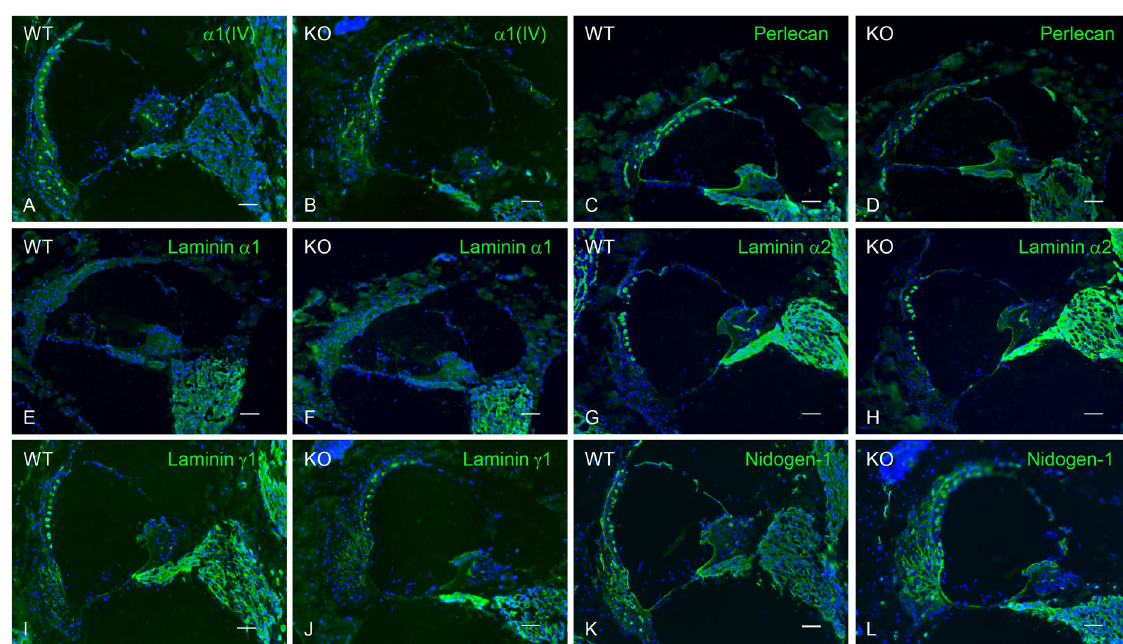
Fig 7. Distribution of major basement membrane components in the cochlea of WT and Col4a6 KO mice. Cryosections were immunostained by antibodies against collagen α 1(IV) chain (A, B), perlecan (C, D), laminin α 1 (E, F), laminin α 2 (G, H), laminin γ 1 (I, J), and nidogen-1 (K, L). Nuclei were counterstained with Hoechst 33258 (blue). No differences are apparent between WT and Col4a6 KO mice. Scale bars = 50 μ